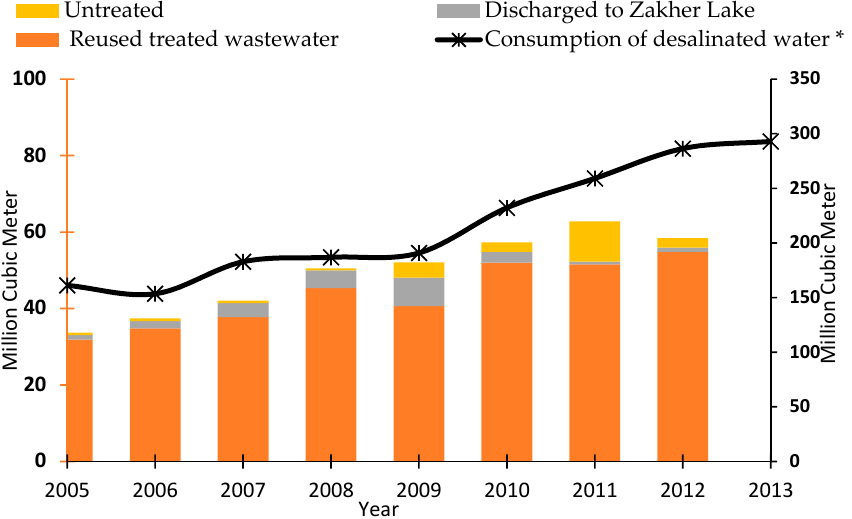
Figure 3. Desalinated water and wastewater figures from Statistics Centre—Abu Dhabi (SCAD) [30] (*Consumption of desalinated water is referred to on the right axis).